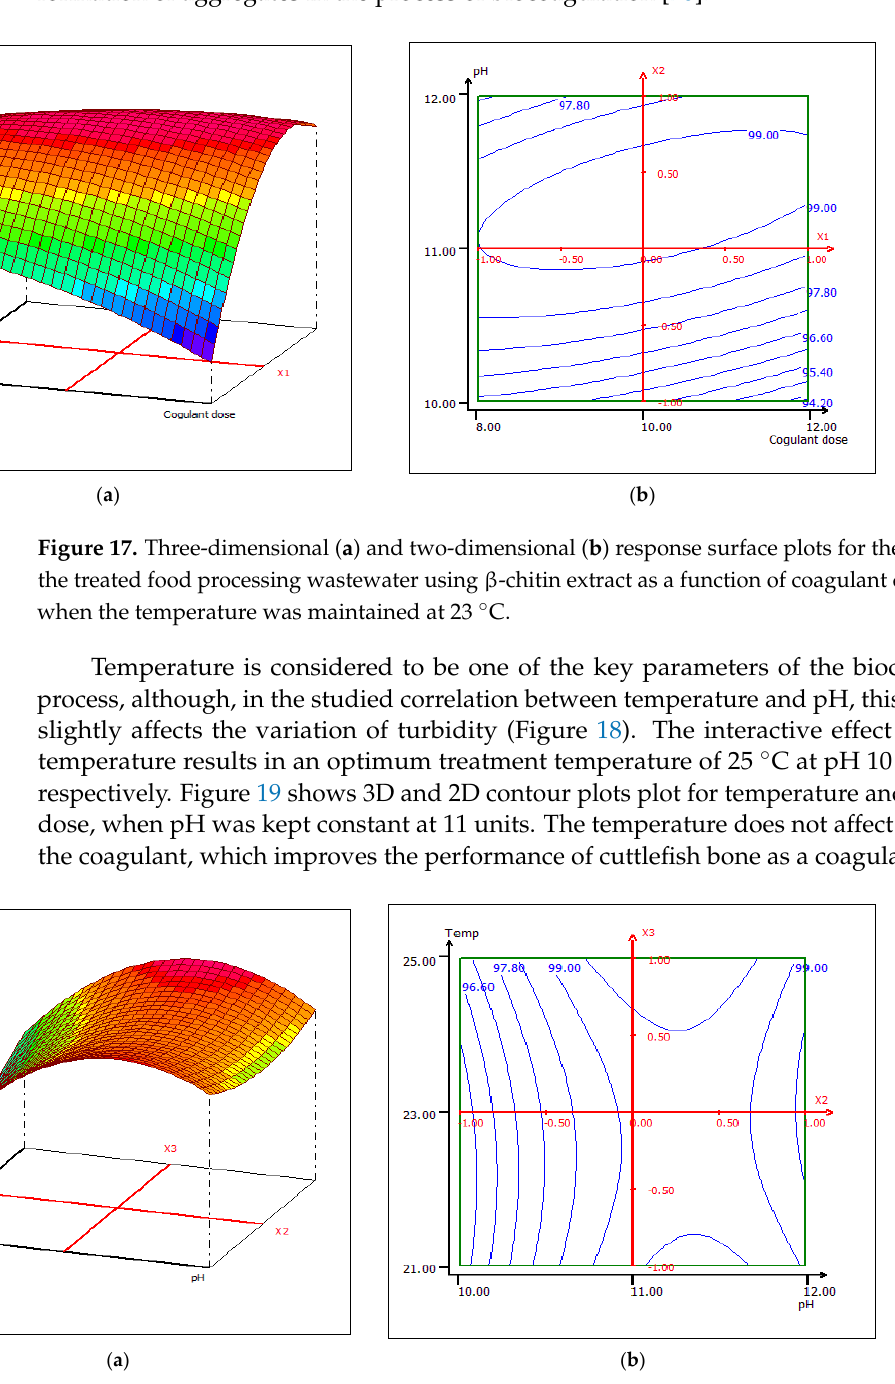
( b ) Figure 19. Three-dimensional ( a ) and two-dimensional ( b ) response surface plots for the turbidity of the treated food wastewater using β-chitin extract as a function of coagulant dose and tempera- ture when the pH was maintained at 11. Subsequently, the maximum of turbidity removal (99.85%) was obtained using 12 mL of biocoagulant at 25 °C at pH 11. In addition, according to ANOVA, pH is an important factor in this study because it affects the overall process of biocoagulation. 3.4.3. Response Surface Plotting and Optimization of BOD 5 Removal